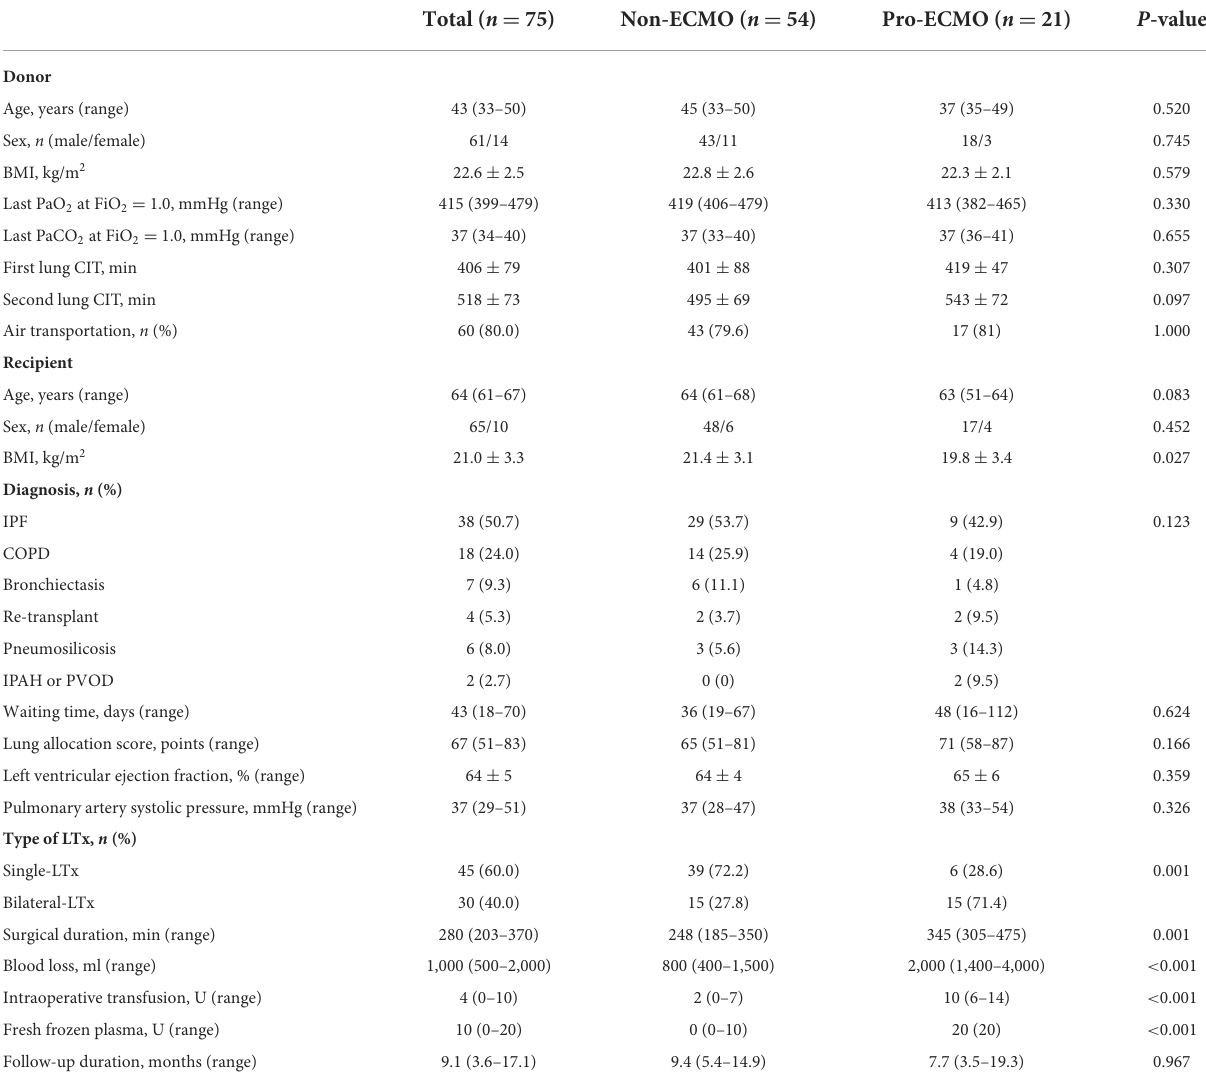
TABLE 1 Patient